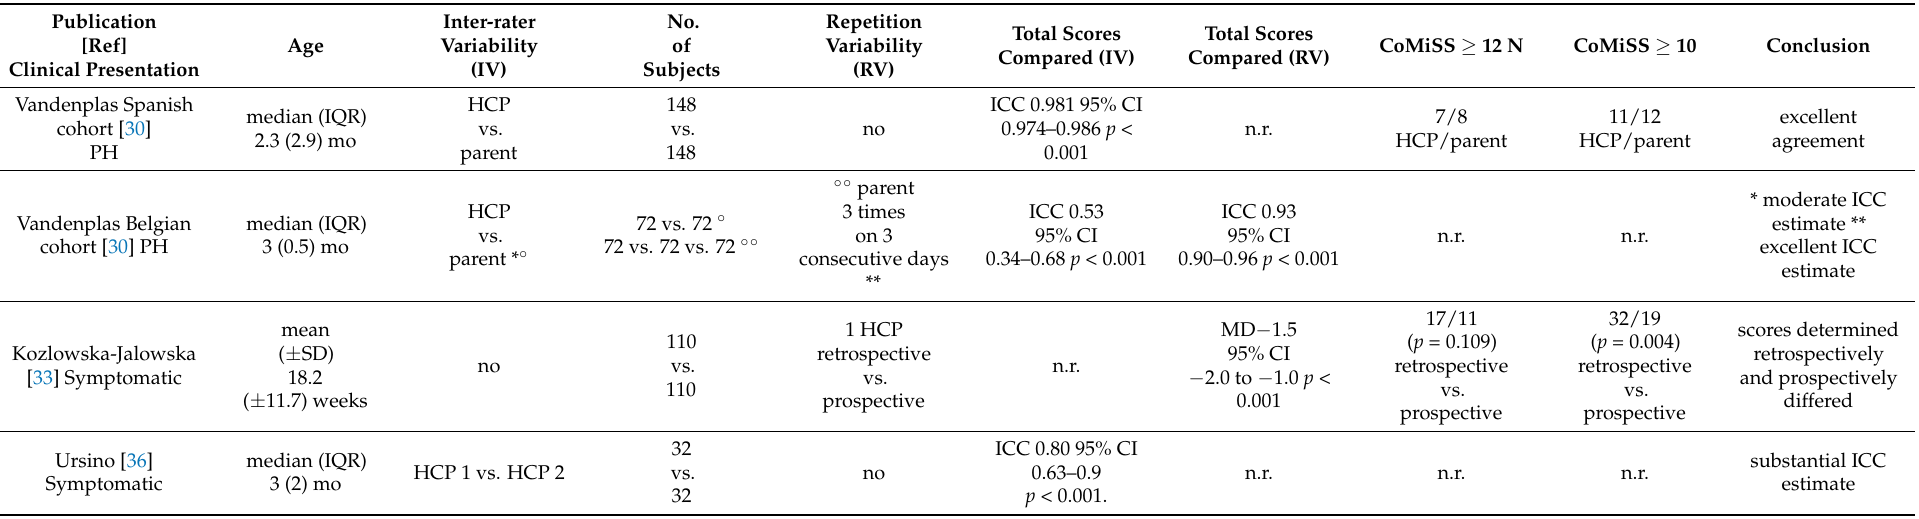
Table 5. Variability of CoMiSS in repeated assessment.